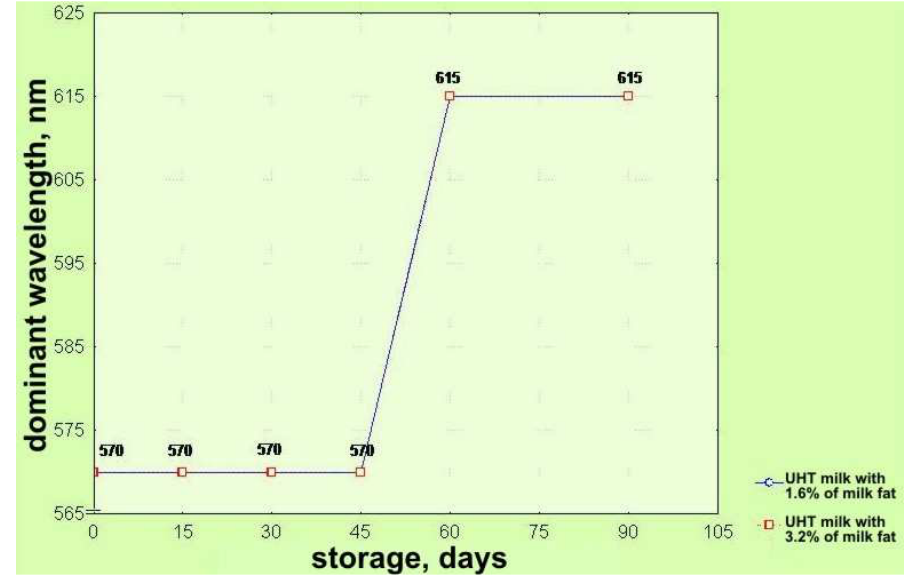
Figure 3 . Effects of storage time on changes of color nuances of UHT milk samples with 1.6% and 3.2% milk fat represented in the CIE system.